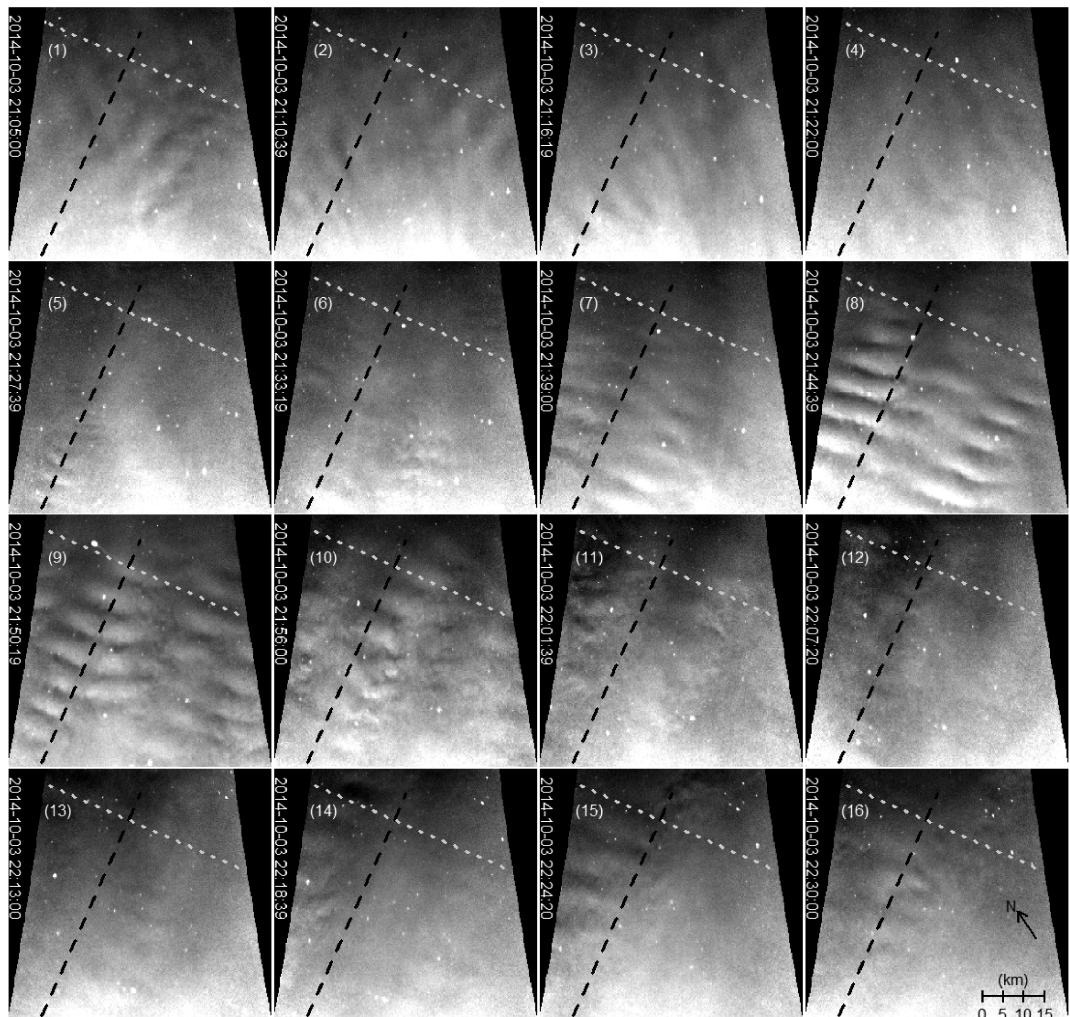
Figure 8. Series of consecutive images within the chosen time interval from 21:05 to 22:30UTC. The black dashed line indicates the trans- verse section through the images used to analyse the smaller-scale wave (I). The grey dotted line shows a transverse section approximately in direction of the wave vector for the investigation of a faint larger wave structure (II) almost perpendicular to the first one. The whole observed area is about 55km (central width of the FOV) × 60km (height of the